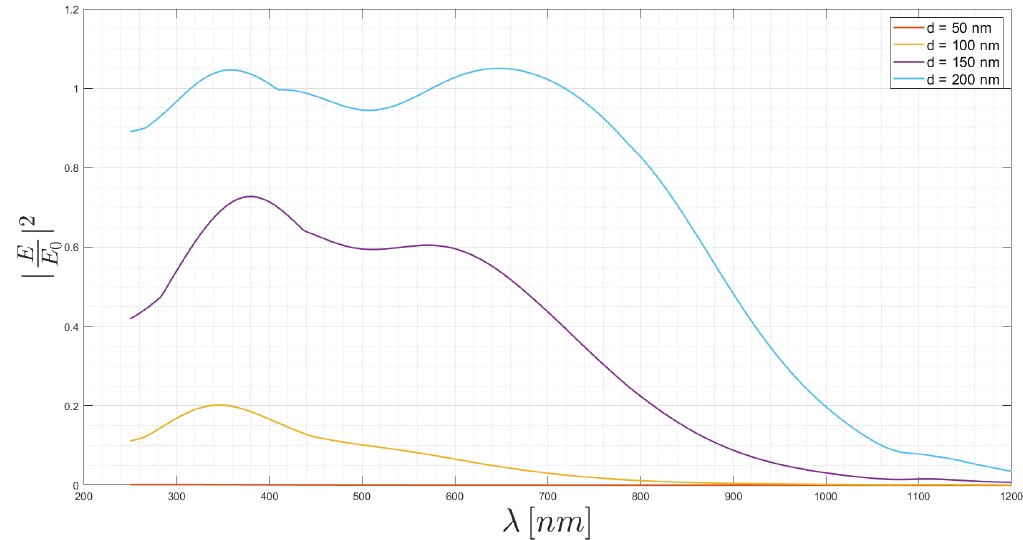
Figure 6. Hole diameter sweep on an aluminum nanostructure with a quartz